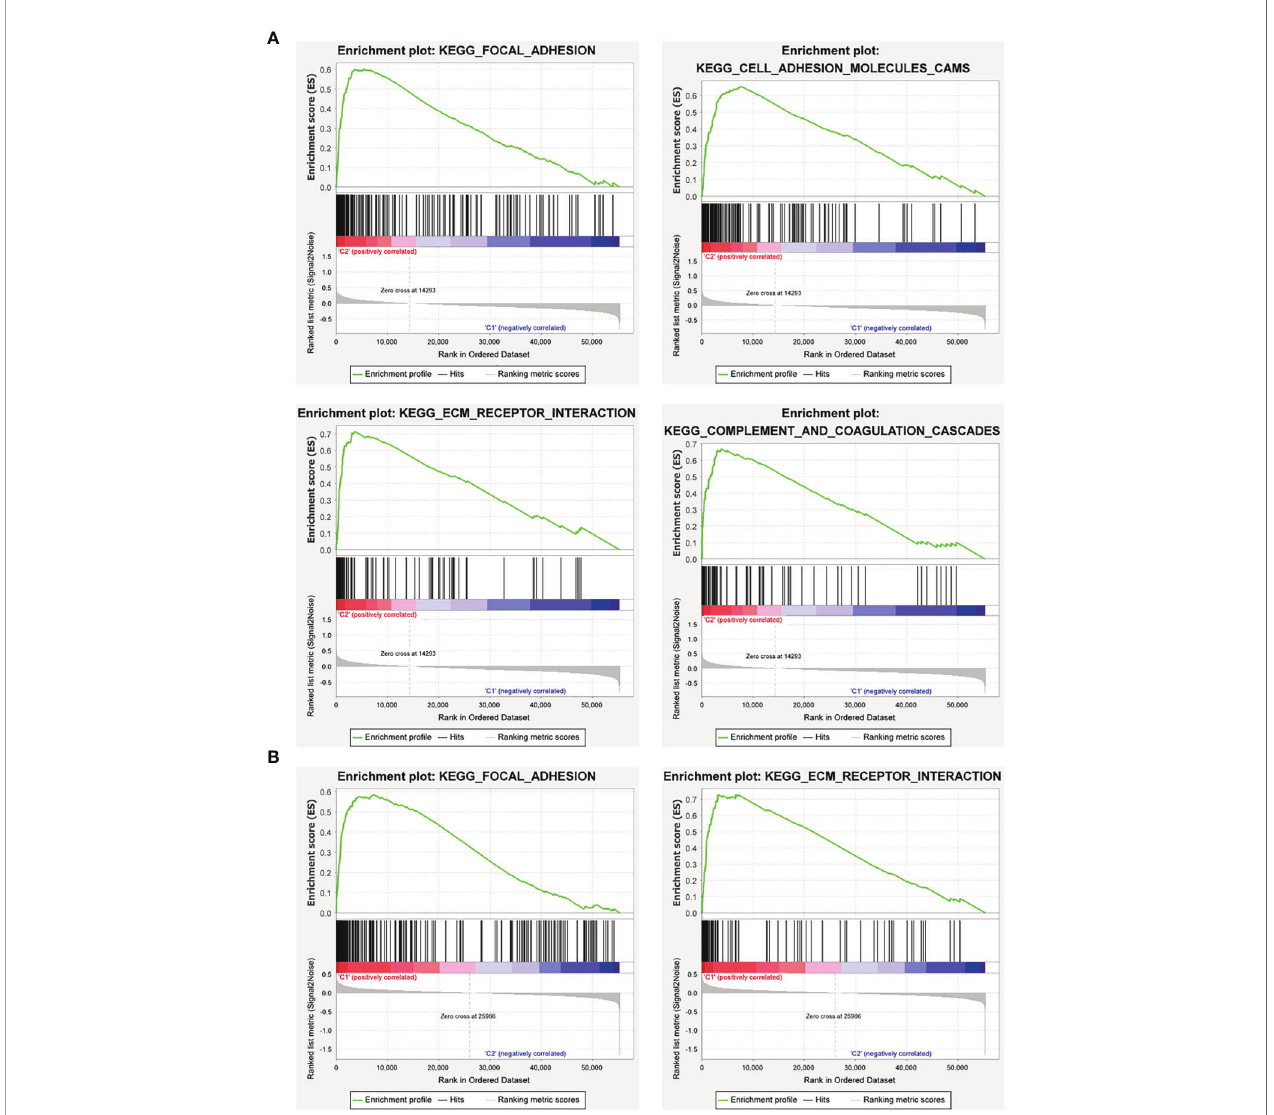
FIGURE 12 | GSEA analysis of the cluster II and the high-risk group. (A) The cluster II was mainly enriched in “ focal adhesion ” , “ ECM-receptor interaction ” , and “ cell adhesion molecules (CAMs) ” , and “ complement and coagulation cascades ” . (B) The high-risk group was mainly enriched in “ focal adhesion ” and “ ECM-receptor interaction ”